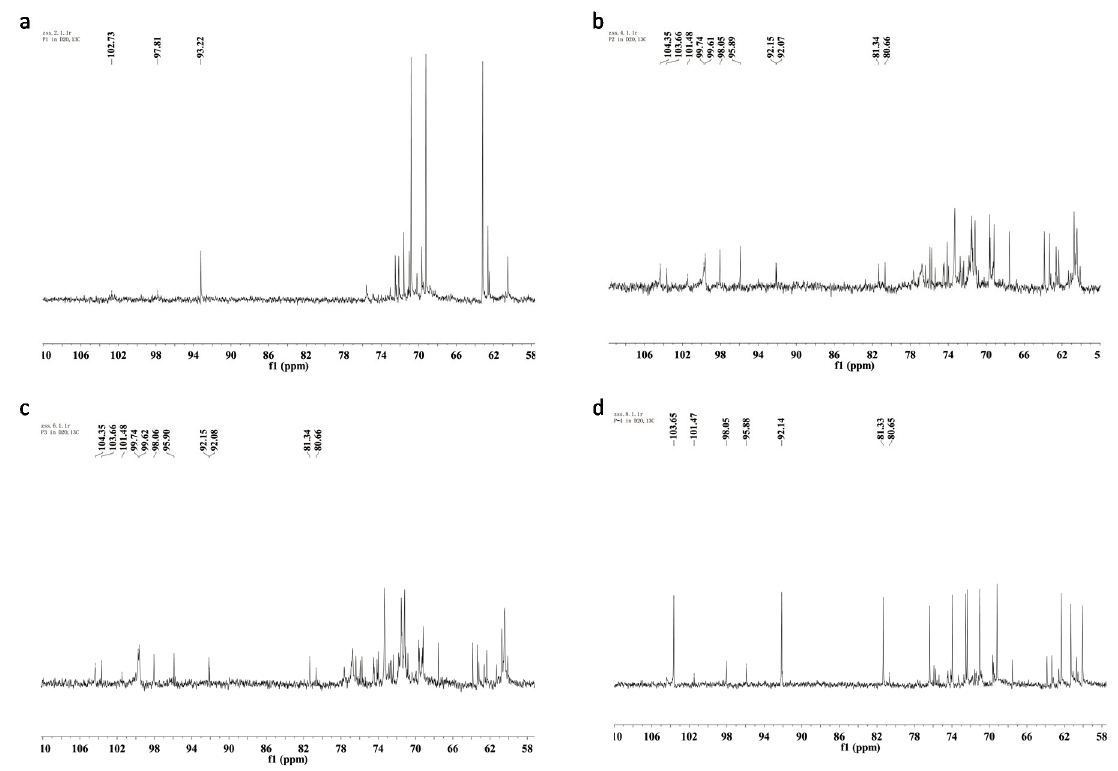
Figure 3. 13 C-NMR spectra (150 MHz, D 2 O, 27 °C) of four polysaccharides from Armillaria mellea . ( a ) SP; ( b ) CMP; ( c ) CFMP; ( d )